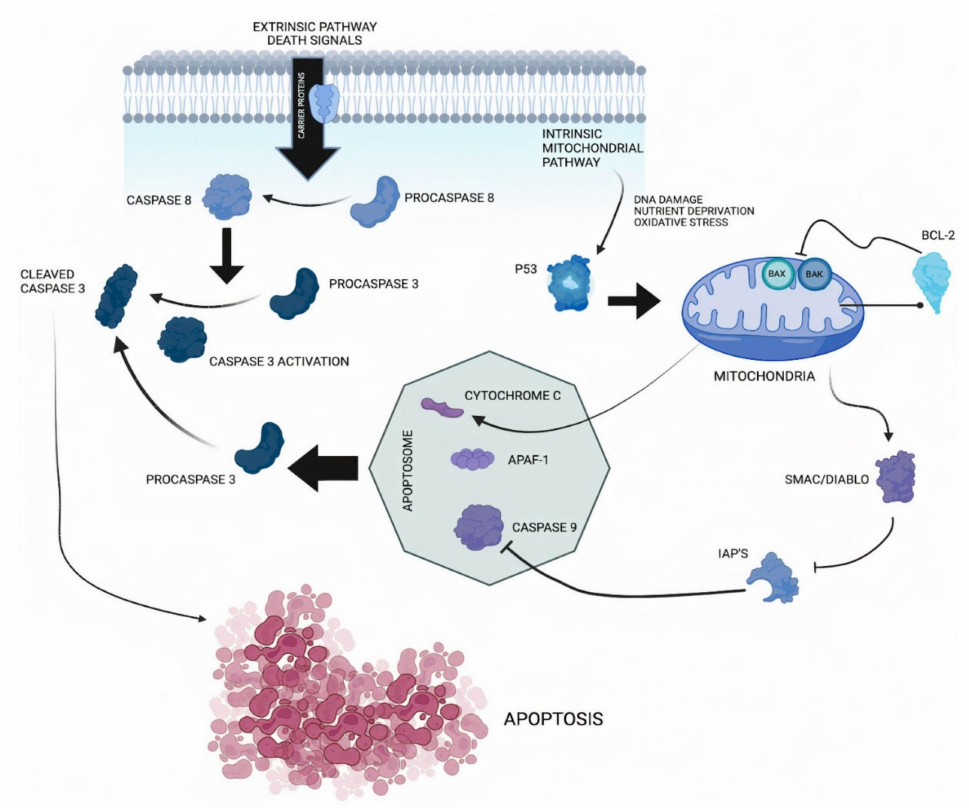
Figure 1. Caspase 3 pathway. The apoptotic process can be triggered by external or internal signals that lead to a common outcome. The extrinsic pathway can be activated when death ligands bind to their corresponding death receptor. Upon ligand binding, an adapter protein is recruited. This leads to the activation of Caspase 8. The intrinsic pathway is initiated by pathological intracellular processes such as DNA damage, nutrient deprivation or oxidative stress. Increased levels of pro- apoptotic proteins such as Bax or Bak (from the family of Bcl-2 proteins) may also be associated with this activation. This triggers the release of cytochrome c from mitochondria, which then binds to and activates apoptosis protease activator protein 1 (Apaf-1), which in turn binds to and activates Caspase 9. Active Caspase 8 or Caspase 9 triggers the cleavage of Caspase 3 through its proenzyme. For apoptosis to take place, inhibitory apoptosis proteins (IAP) must be inactivated by Smac/Diablo